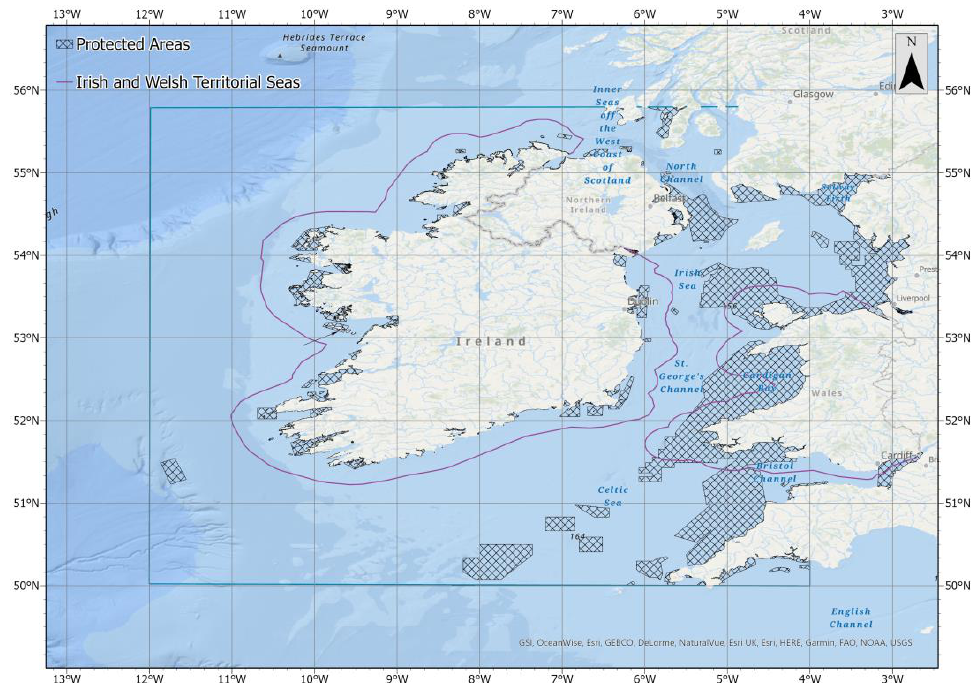
Figure 21. Protected areas throughout the Selkie study area.